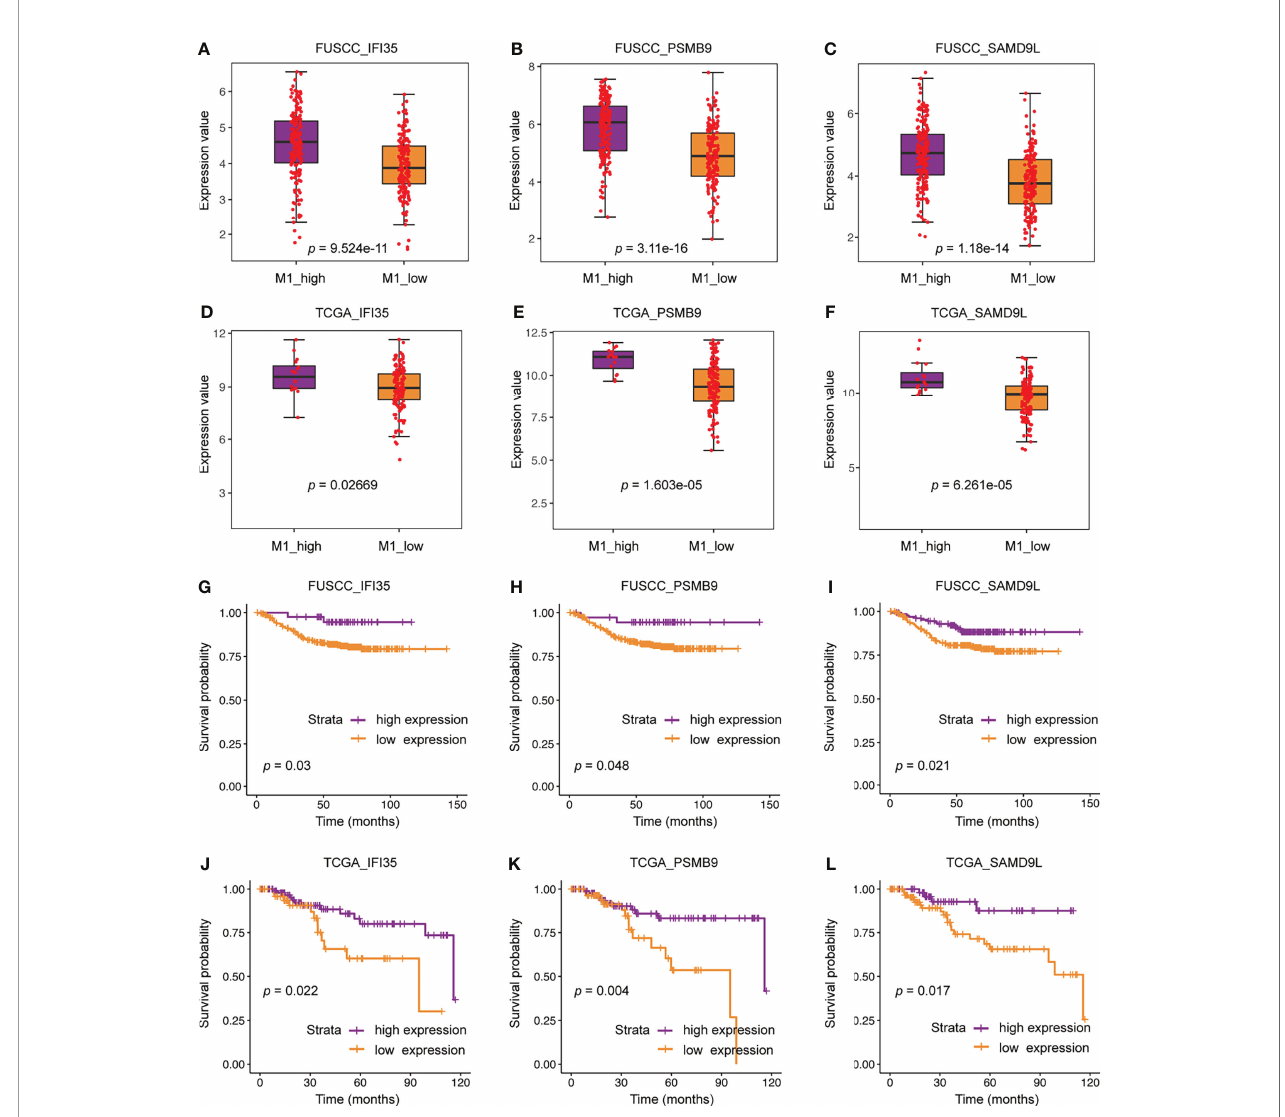
FIGURE 6 | The clinical signi fi cance of three representative genes including IFI35, PSMB9, and SAMD9L. (A – F) Expression differences of three representative genes between M1 macrophage high and low in fi ltration groups. (G – L) The relationship between three representative genes and patients ’